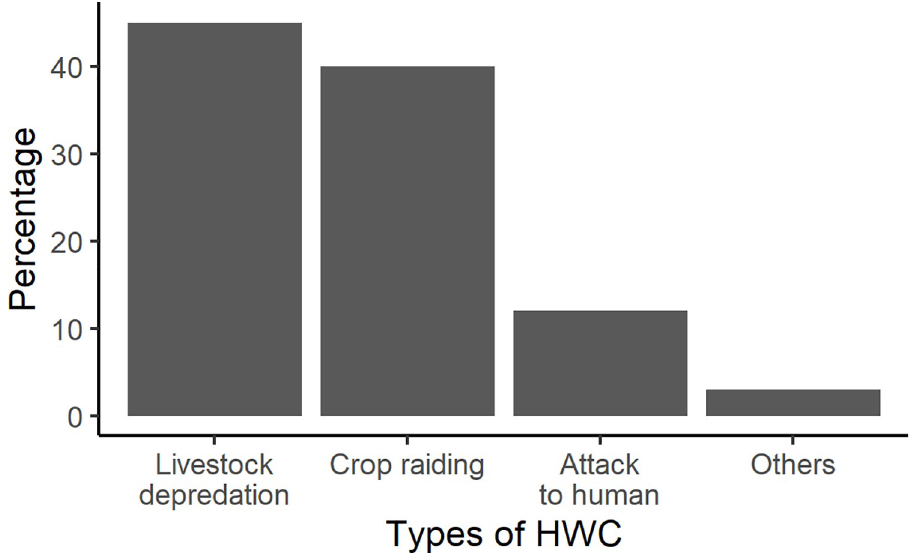
Fig 2. Types of HWC in PLSTK districts during 2011 to